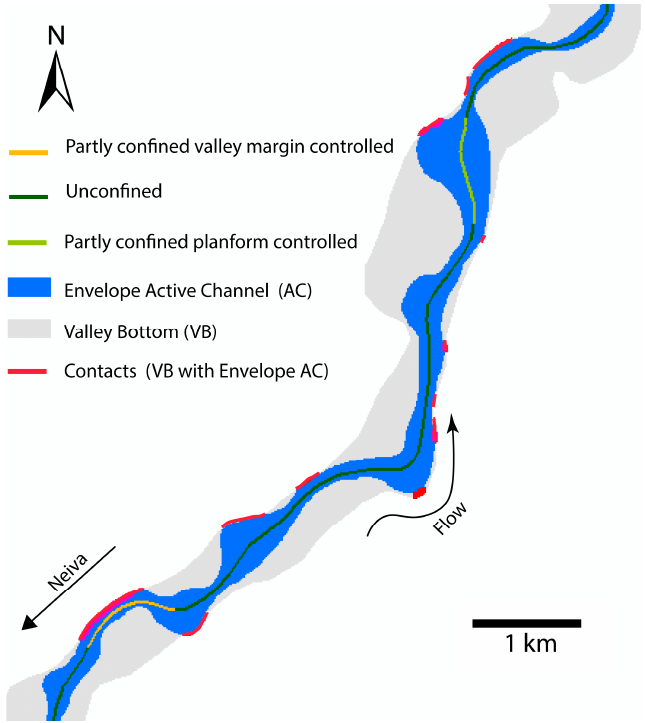
Figure 4. Examples of unsatisfactory output we obtained with O’Brien et al. [6] algorithm (Upper Magdalena River, approx. 10 km downstream of Neiva town: 867490.92; 823535.51 MAGNA Colombia Bogota, see Figure 3 to locate the town in the